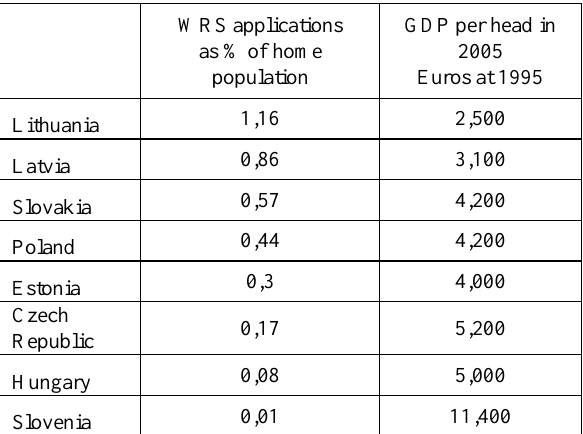
Table 12. WRS Applications May 2004 – Sept 2005 as a % of 2005 population GDP per head in 2005